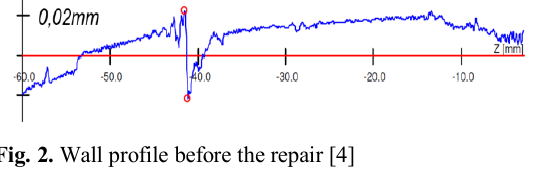
Fig. 2. Wall profile before the repair [4]